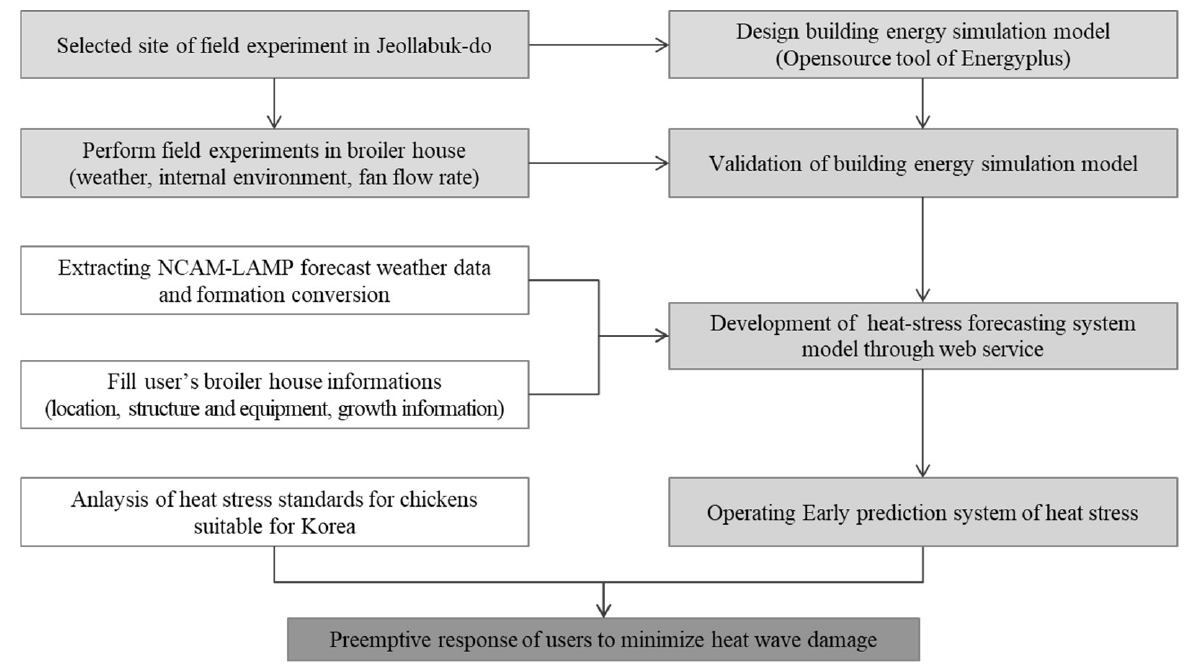
Figure 1. Research flow for heat stress energy model and forecasting system development procedure.